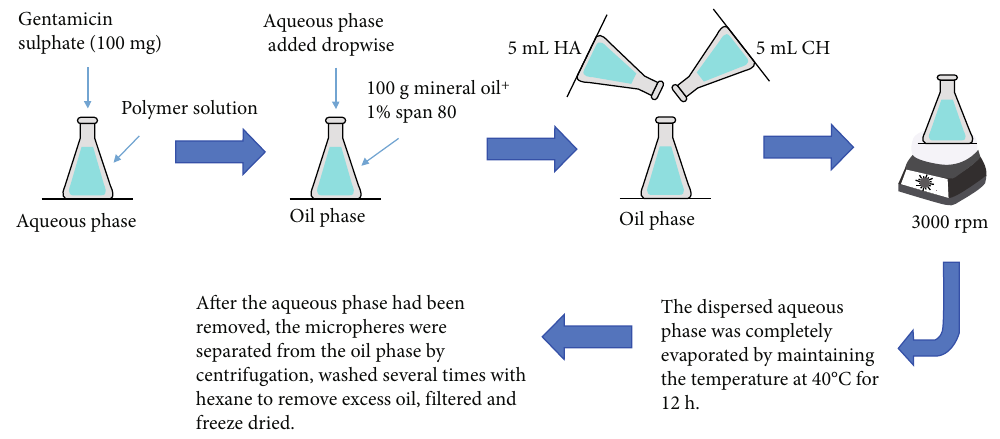
Figure 26: Schematic representation of water-in-oil (w/o) emulsi fi cation solvent evaporation technique [107]. A specific ratio of each 1. The pH of the solution was polymer solution giving a total then reduced using 0.1 M HCl polymer solution volume of 200 to a point when coacervation ml was mixed in a 500 ml beaker occurred (pH 3.6)